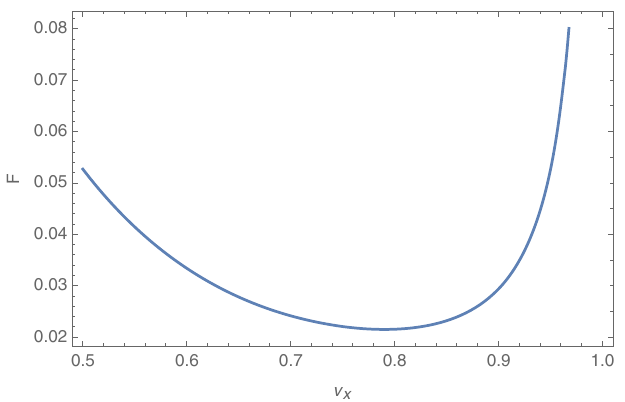
FIG. 6. The form factor of emittance in Eq. (15) as a function of the horizontal betatron